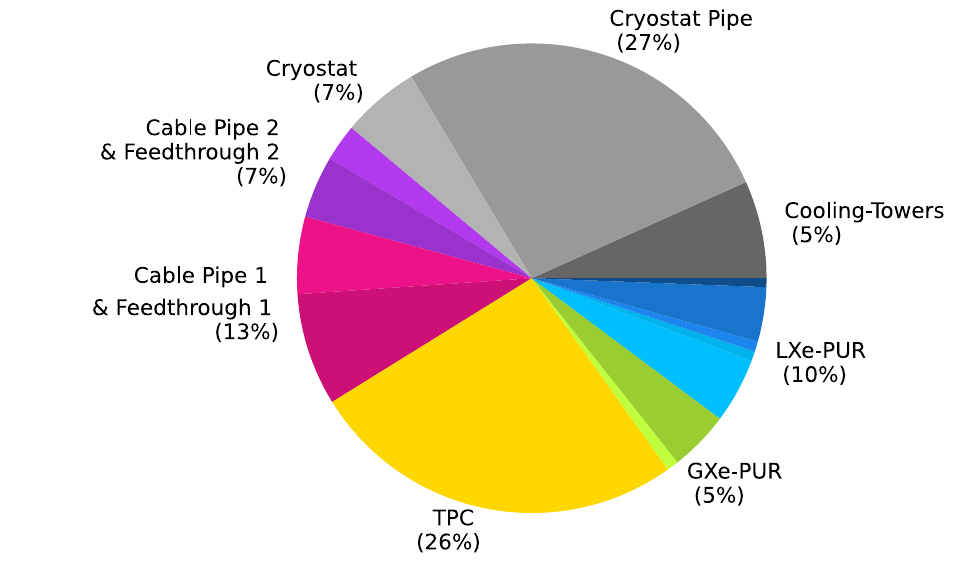
Fig. 3 The different subsystem contributions to the overall 222 Rn emanation rate in XENONnT, adding up to 35.7( + 4 . 5 − )mBq. The colors 5 . 9 correspond to the scheme used in Fig. 2. Only central values from Table 6 in this work and Figure 2 in [10] have been used. The radon emanation from the Rn-DST system is not taken